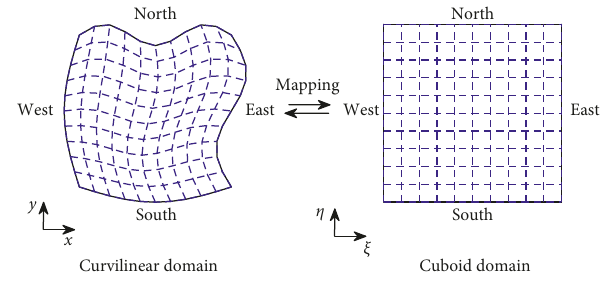
Figure 1: Coordinate